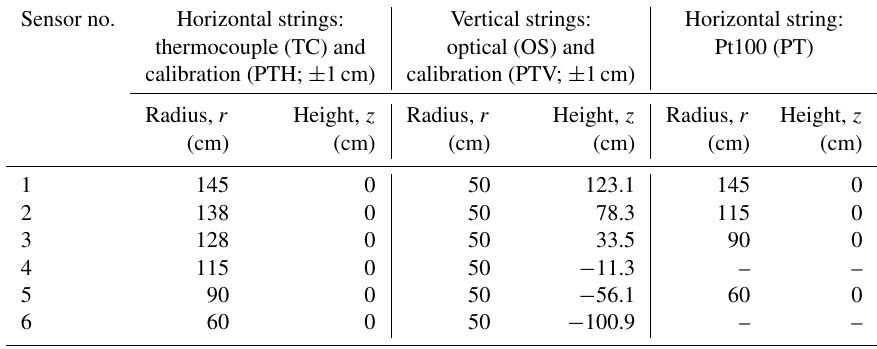
Table 1. Position of the temperature sensors in CLOUD. The CLOUD chamber is a cylinder of 150cm radius ( r ) and approximately 400cm height ( z ). The origin of the cylindrical coordinate system is located in the centre of the chamber, with the z axis pointing vertically upwards (Fig. 1). The calibration strings, PTH and PTV, have Pt100 sensor locations that are located within about 1cm of the indicated sensor locations for the TC and OS strings, respectively. The calibration strings, which are only installed during calibration measurements, are displaced laterally from the TC string by (cid:49)z = − 20cm (PTH) and from the OS string by 10cm azimuthally (PTV). Sensor no.